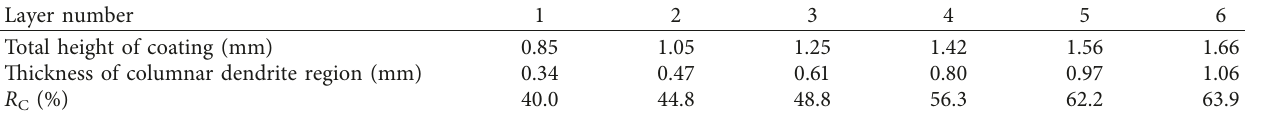
Table 5: Size of the columnar dendrite region and its variation with the number of deposited layers.